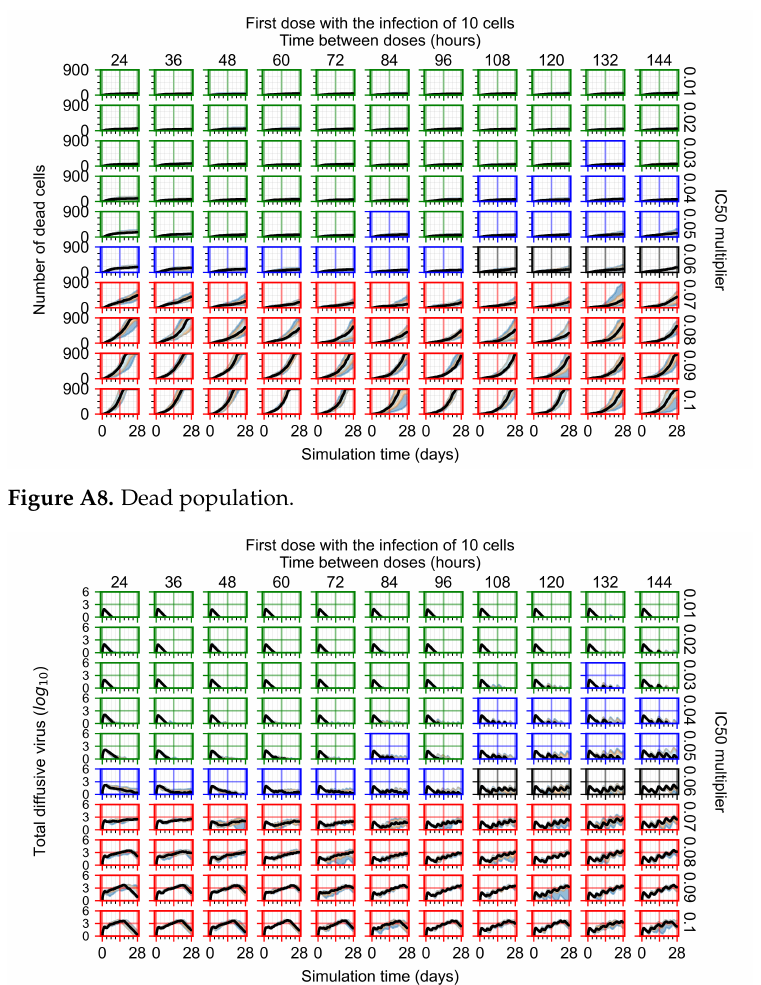
Figure A9. Extracellular diffusive virus quantities (arbitrary units), Y axis in log scale, and exponent values as tick marks.